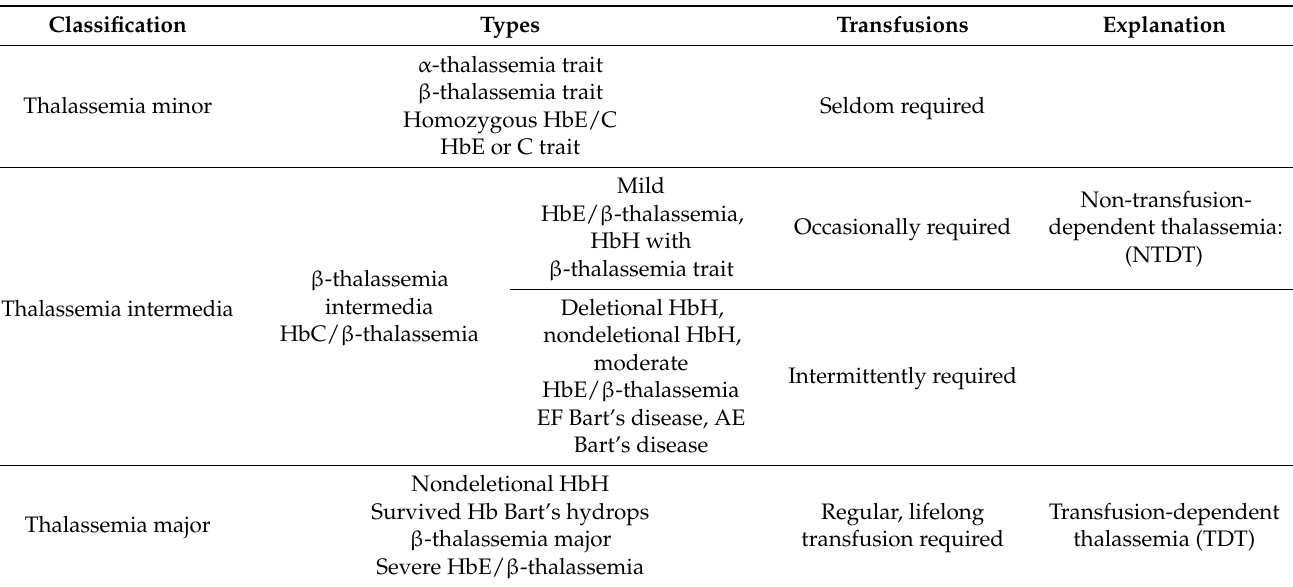
Table 2. Classification of thalassemia (adapted from